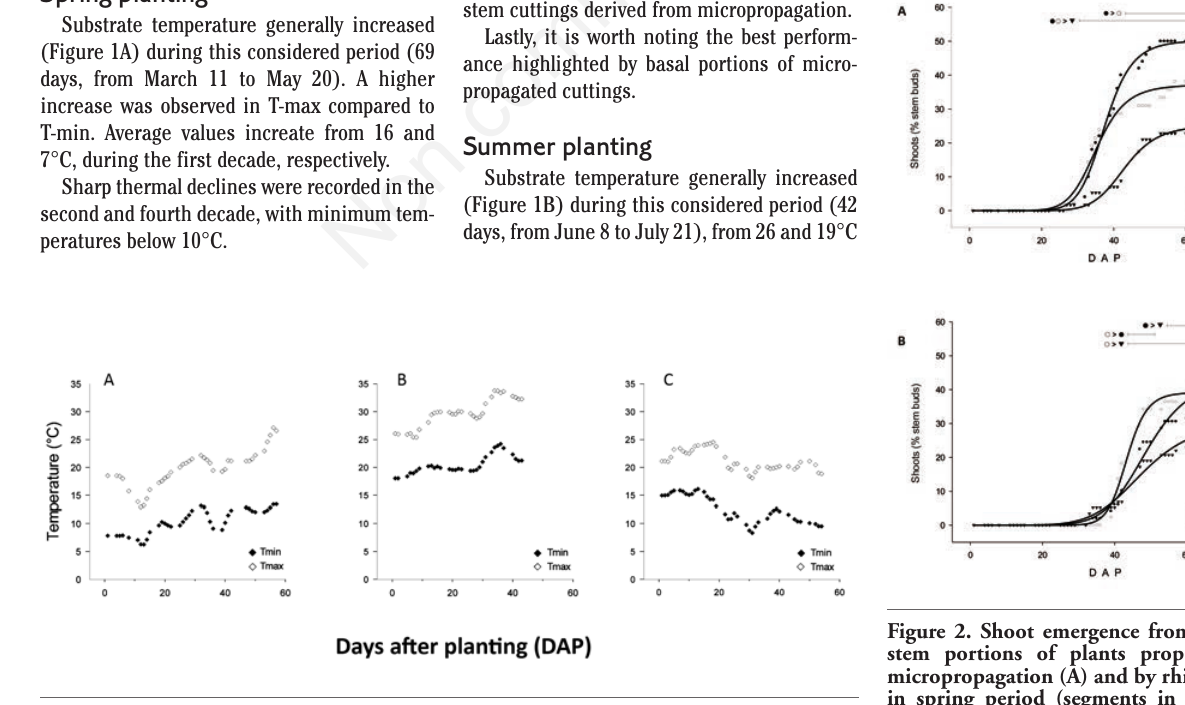
Figure 1. Maximum and minimum substrate temperatures recorded in spring (A), sum- mer (B) and autumn (C) observation periods.